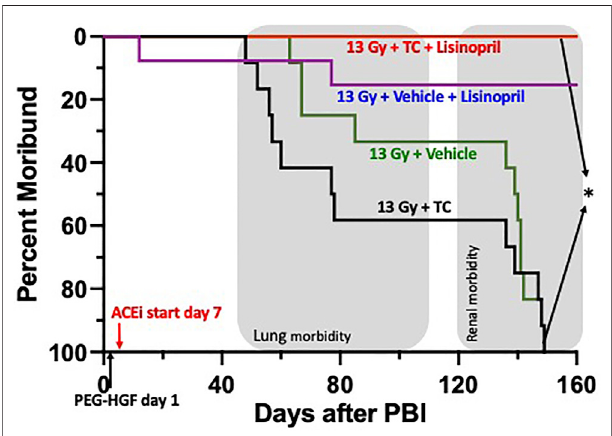
FIGURE9| Kaplan-MeierplotrepresentingmorbidityfromDEARE upto 160 days post 13 Gy partial body irradiation with one hind limb shielded (leg- out PBI). The triple combination (TC, consisting of PEG-hG-CSF, PEG mGM- CSF and PEG hIL-11), or vehicle were given subcutaneously 24 h post PBI and the ACE inhibitor, lisinopril, was started in the drinking water 7-days post-irradiation. All irradiated rats were given supportive care. All irradiated rats that received TC + lisinopril survived to 160 days as compared to 100% morbidity for irradiated rats that received TC alone ( p < 0.0001). Survival of irradiated rats given vehicle + lisinopril was over 90%, while irradiated rats given only the vehicle were moribund before 160 days. Shaded (gray) areas represent the timing for the lung and renal injuries.